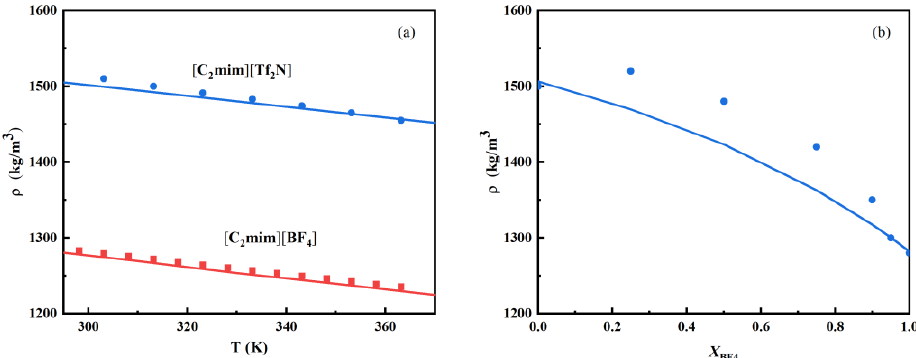
Figure 2. ( a ) Bulk density of pure ILs [C 2 mim][Tf 2 N] and [C 2 mim][BF 4 ] at T = 293.1K and atmospheric pressure. Symbols: experimental data [48,49] ; lines: model results. ( b ) Density of